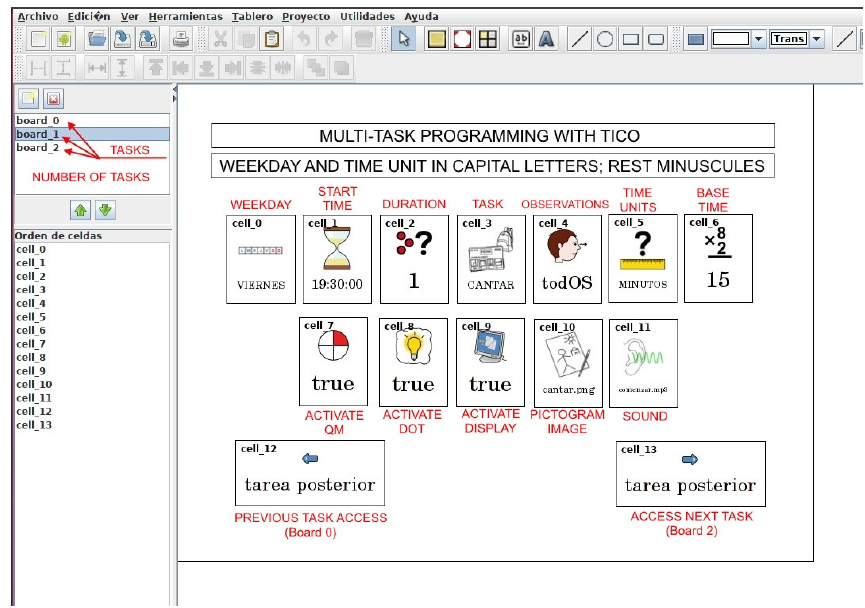
Figure 16. Elaboration of class agenda with TICO for later import from TO service.